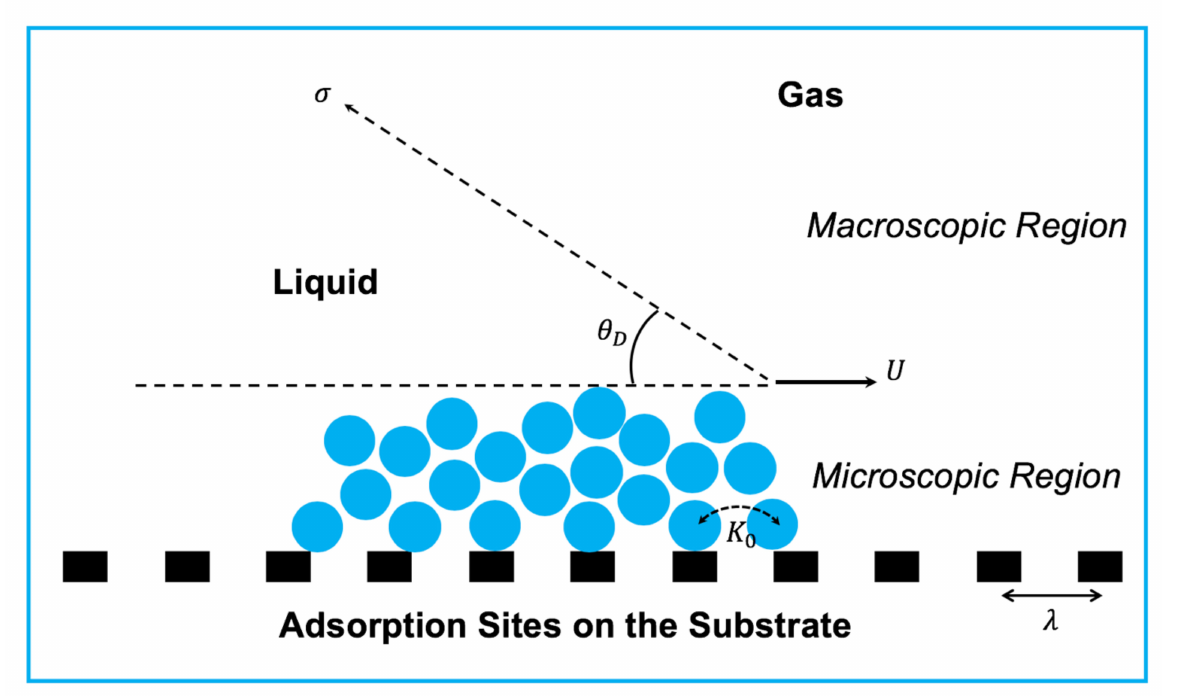
Figure 6. Schematic representation of molecular kinetic theory to explain the physics of dynamic contact line based on two parameters: λ and K 0